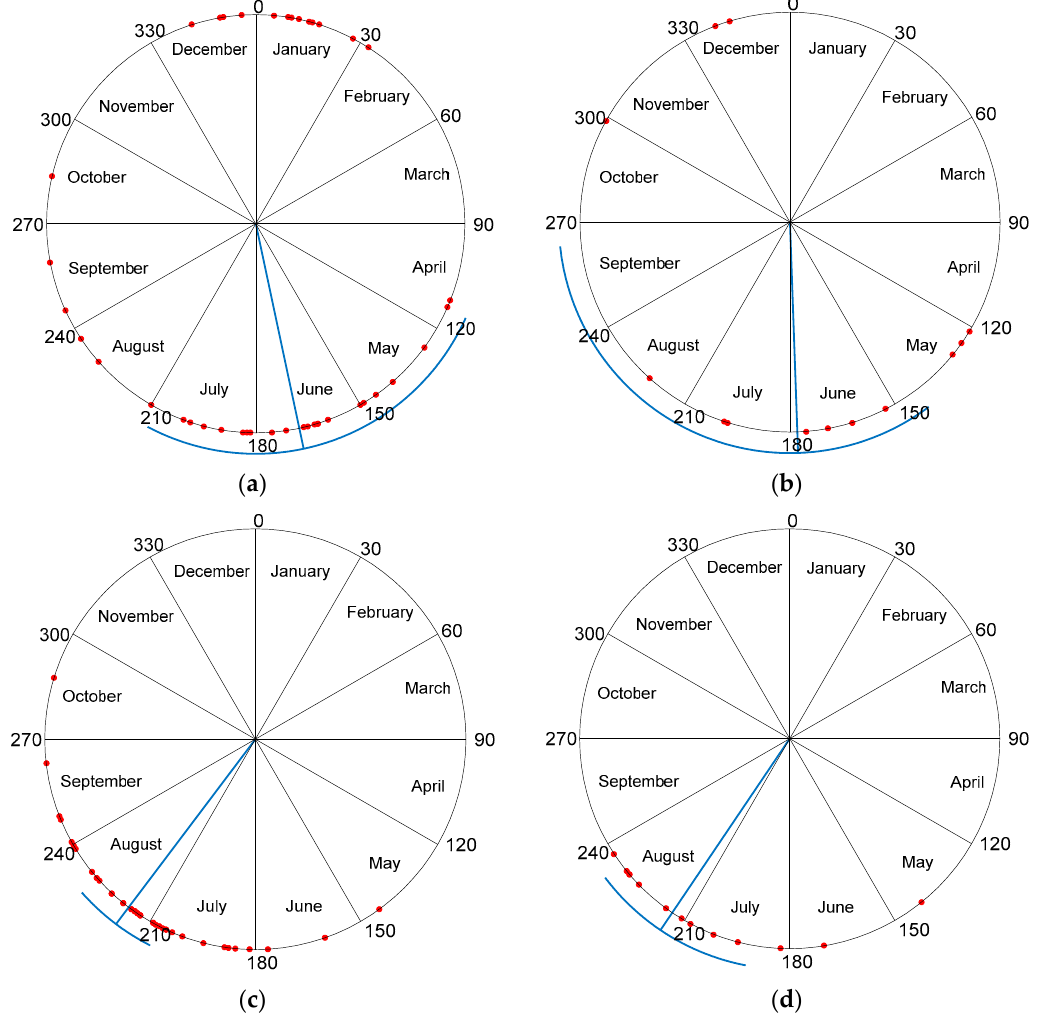
Figure 5. Timing of annual 1-day minimum in ( a ) the pre-impact period and ( b ) the post-impact period, and the timing of annual 1-day maximum in ( c ) the pre-impact period and ( d ) the post-impact period.